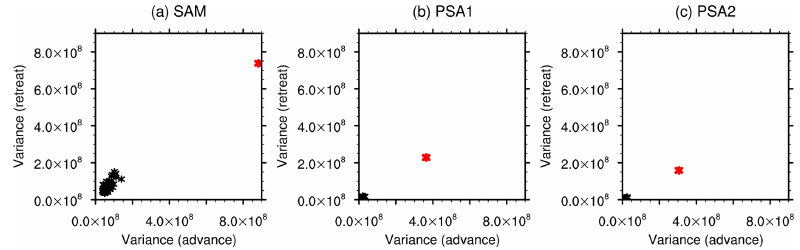
Figure 6. Absolute variance during sea ice advance and retreat of the corresponding principal component time series for (a) SAM, (b) PSA1, and (c) PSA2. The black markers indicate CMIP5 ensemble members; the red markers indicates ERA-Interim reanalysis.